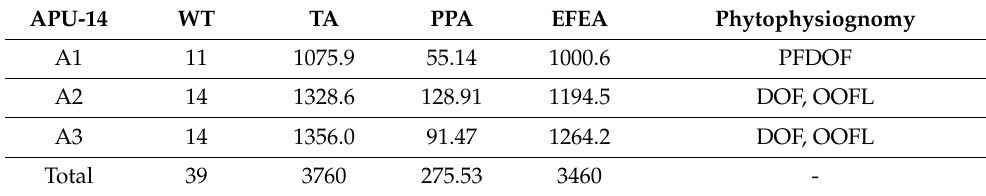
Figure 1. Location of the study areas and gaps and subdivisions of the Annual Production Unit No. 14 (APU-14) of the Forest Management Unit (FMU) at Fazenda Uberlândia, Portel, Pará state. Table 1. Quantification of areas and phytophysiognomies in the studied Annual Production Unit.